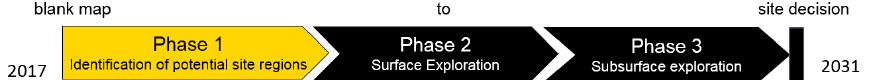
Figure 1. General succession of the phases within the stepwise German siting process. While Phase 1 only assess already available data, Phases 2 and 3 will base on results of surface and subsurface exploration